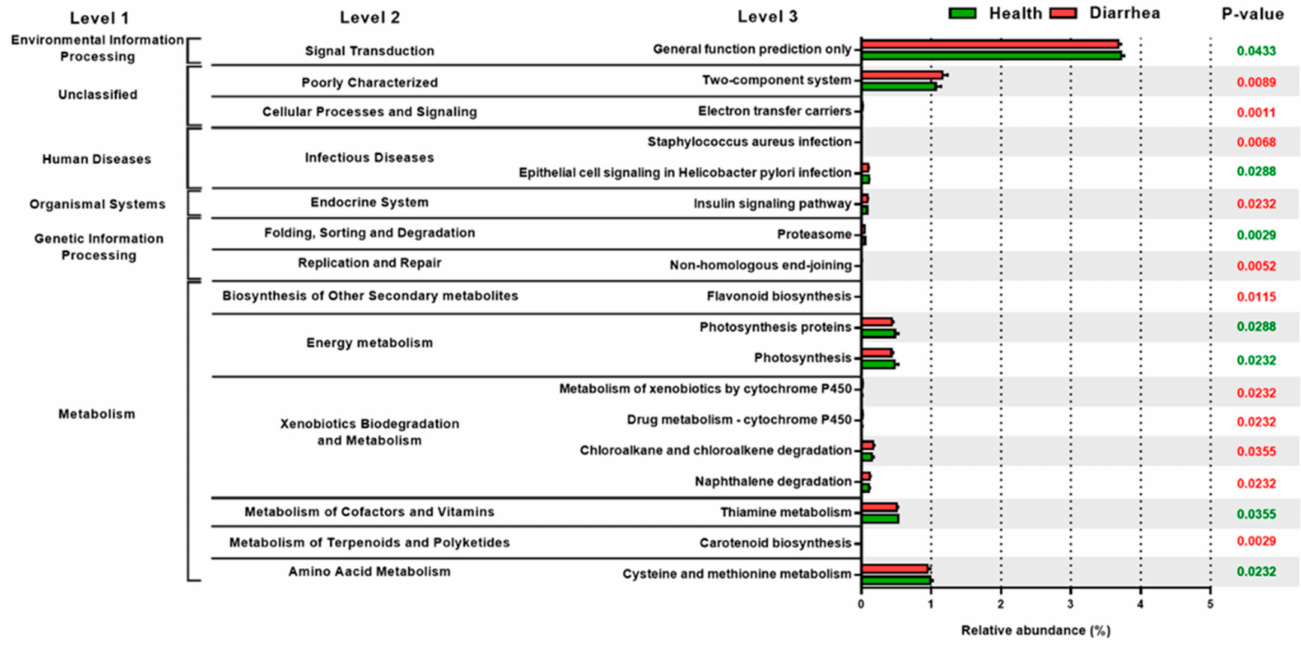
Figure 4. Comparison of the relative abundance of PICRUSt functional prediction of gut microbiota between healthy and diarrheic calves. The results represent means ± SD analyzed by Mann–Whitney U test. District gene categories are selected according to significant differences ( p < 0.05) in KEGG pathway level